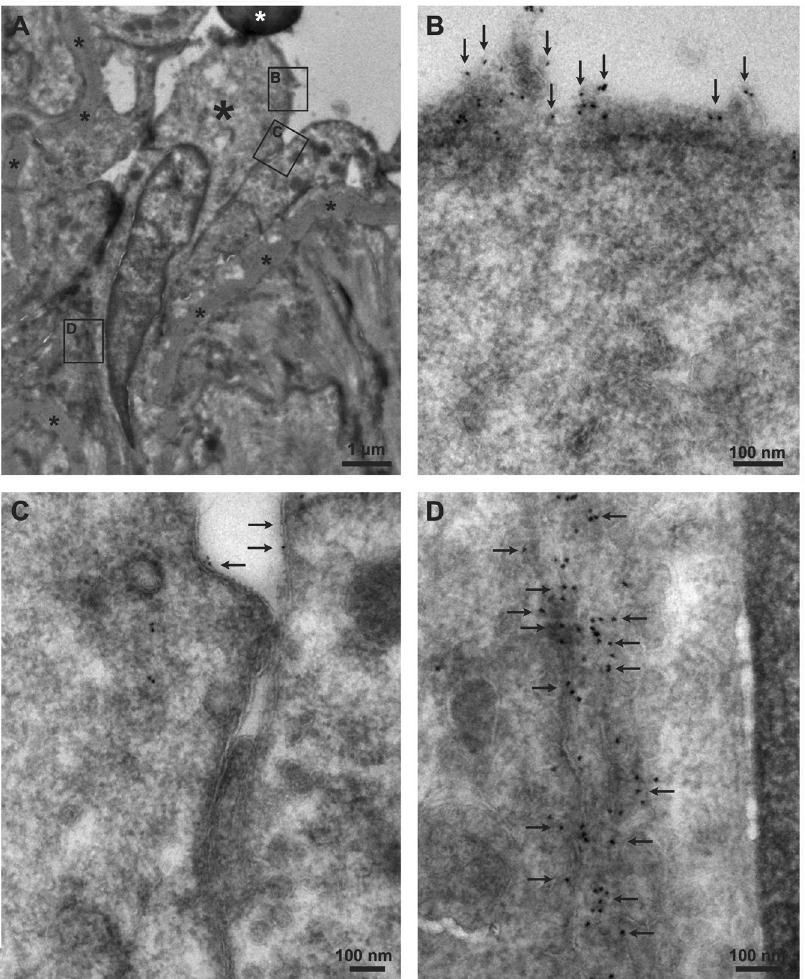
Figure 4. Electron microscopical localization of K Ca 2.3 in endothelial cells of sinusoids in corpus cavernosum from a wild type mouse. ( A ) Endothelial cells located in a sinusoid of corpus cavernosum (one of the cells is represented by a large black asterisk), small black asterisks represents the basement membrane of the endothelium. White asterisk represents an erythrocyte. ( B , C ) K Ca 2.3 immunoreactivity is seen in the apical plasma membrane of the endothelial cells (represented by 10 nm gold particles, arrows, enlargements of inset B and C ). ( D ) Immunoreactivity for K Ca 2.3 channels is seen occasionally in the lateral membrane of endothelial cells (arrows, enlargement of